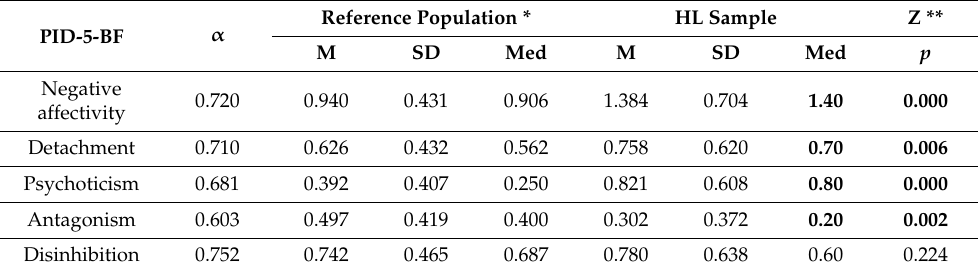
Table 4. Scores on maladaptive personality traits.